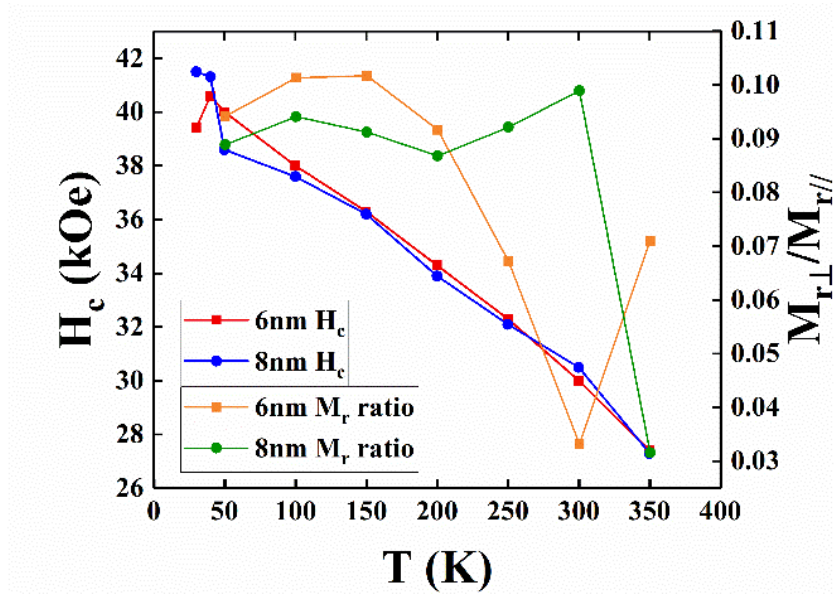
Figure 4. Temperature dependence of out-of-plane coercivity and remanence ratio of FePt (B, Ag, C)/MoC/MgTiON/CrRu films.